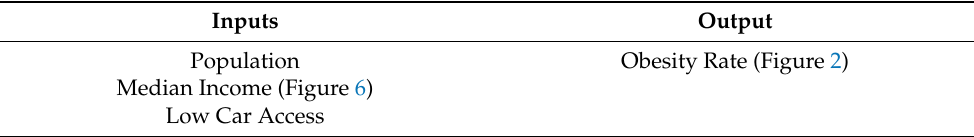
Table 6. Variables for multiple linear regression model development.